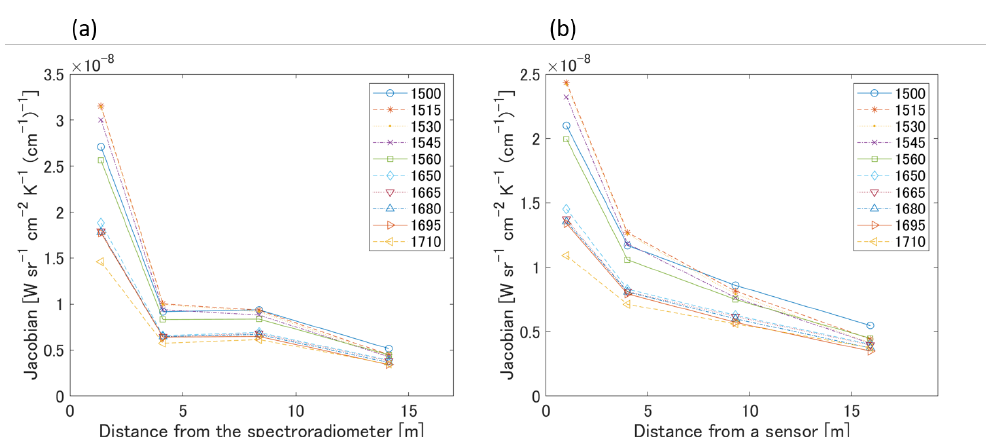
Figure 6. Simulated Jacobian (10 selected channels). For any channel, the first-layer value is particu- larly large and tends to monotonically decrease with distance. ( a ) Indoor experiment (Cases A1–A4).